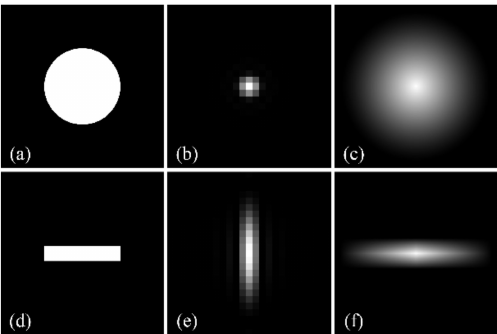
Figure 3. Comparison of circular and rectangular apertures. ( a – c ) A 0.5m circular aperture and its PSF and OTF. ( d – f ) A 5:1 aspect ratio, 0.5m length rectangular aperture and its PSF and OTF. The pixel size in ( b ) and € is 4.5 µ m × 4.5 µ m.